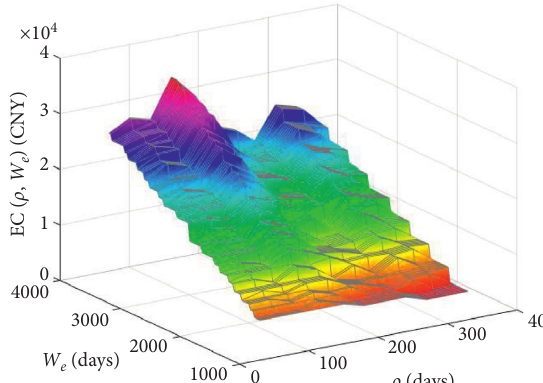
Figure 9: Change trend of system EW cost with different EW periods and inspection intervals.